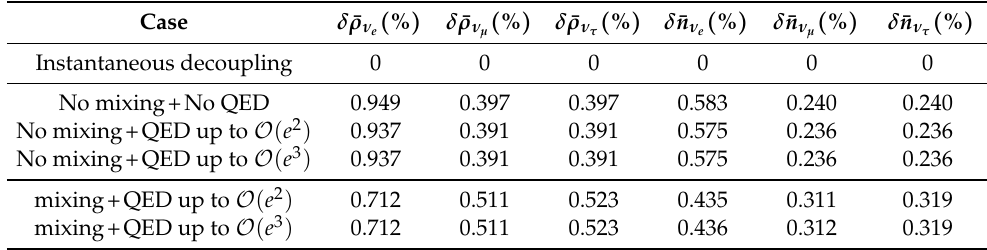
≡ ( ρ ν − ρ eq ) / ρ eq ν ν and α α